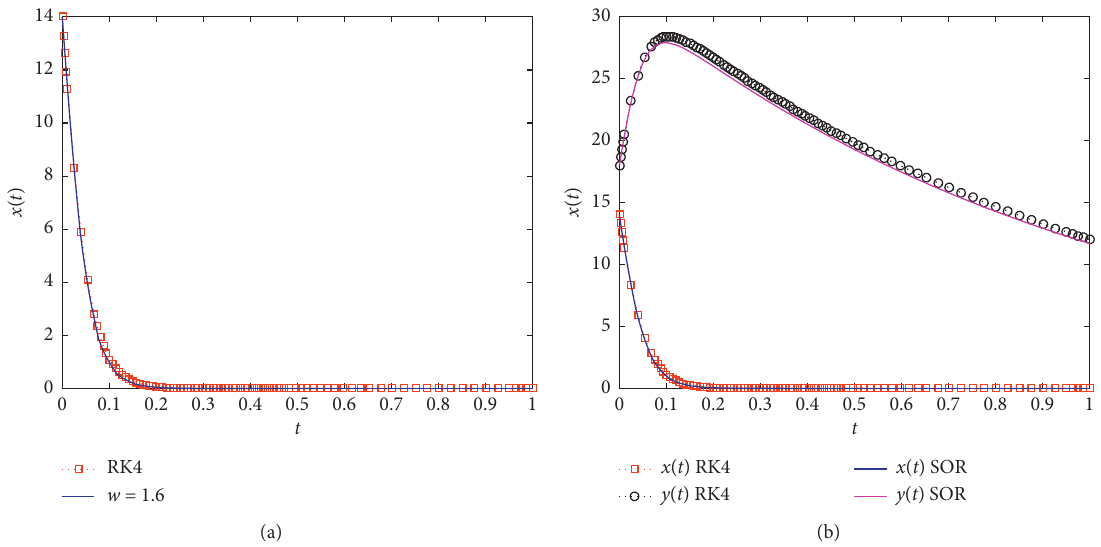
Figure 5: Comparison of multistage three term SOR-like and RK4 for x ( t ), y ( t ), and ω � 1 .